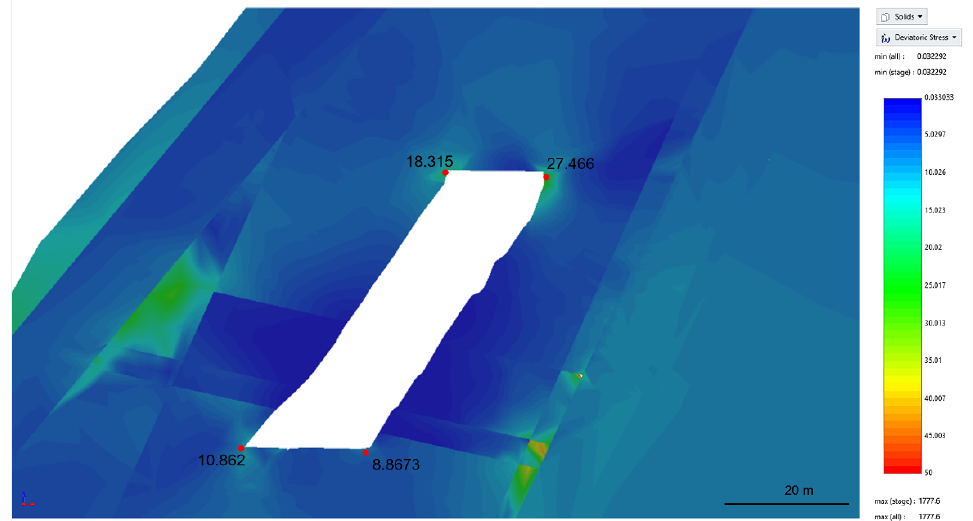
Figure 18. Deviatoric stress ( σ 1 – σ 3 ) of Section S2 calculated in MPa.